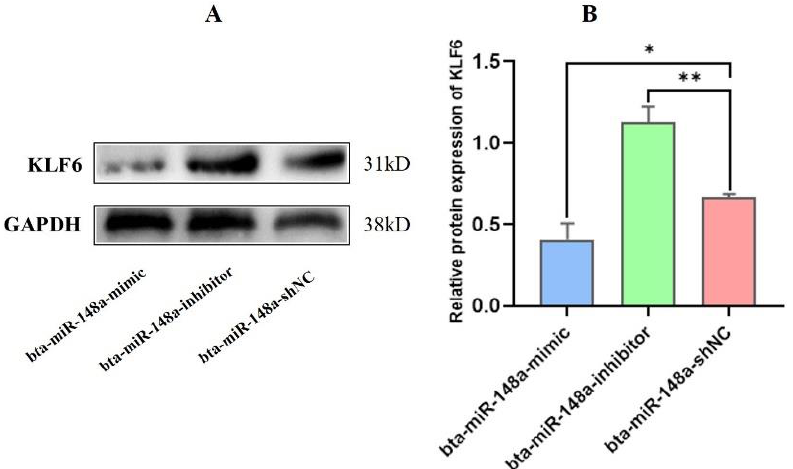
Figure 5. Relative expression of KLF6 protein in BMECs transfected with bta-miR-148a-mimic, bta- miR-148a-inhibitor, and bta-miR-148a-shNC. ( A ); Western blot bands for KLF6 protein in different experimental groups. ( B ); Quantification of KLF6 protein expression. * p < 0.05, ** p <